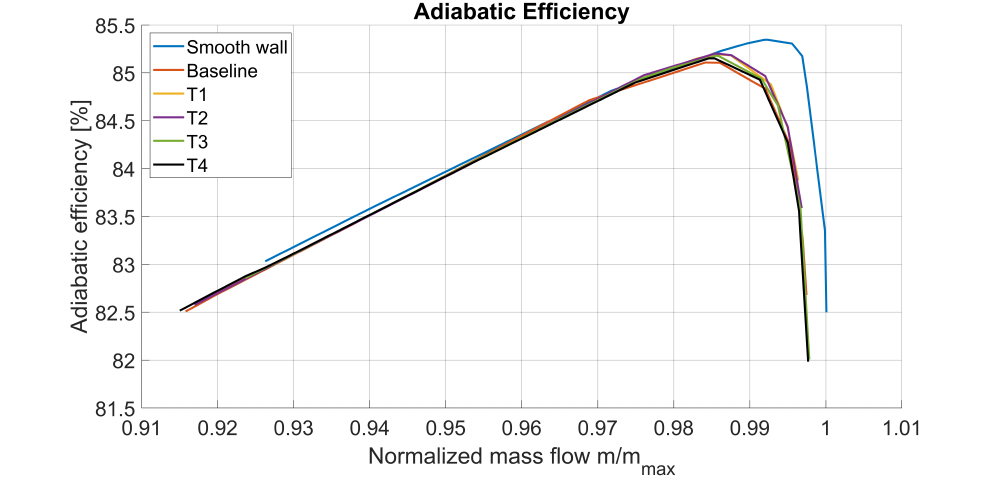
Figure 17. Adiabatic Efficiency T-shape configurations compared to the smooth wall case.